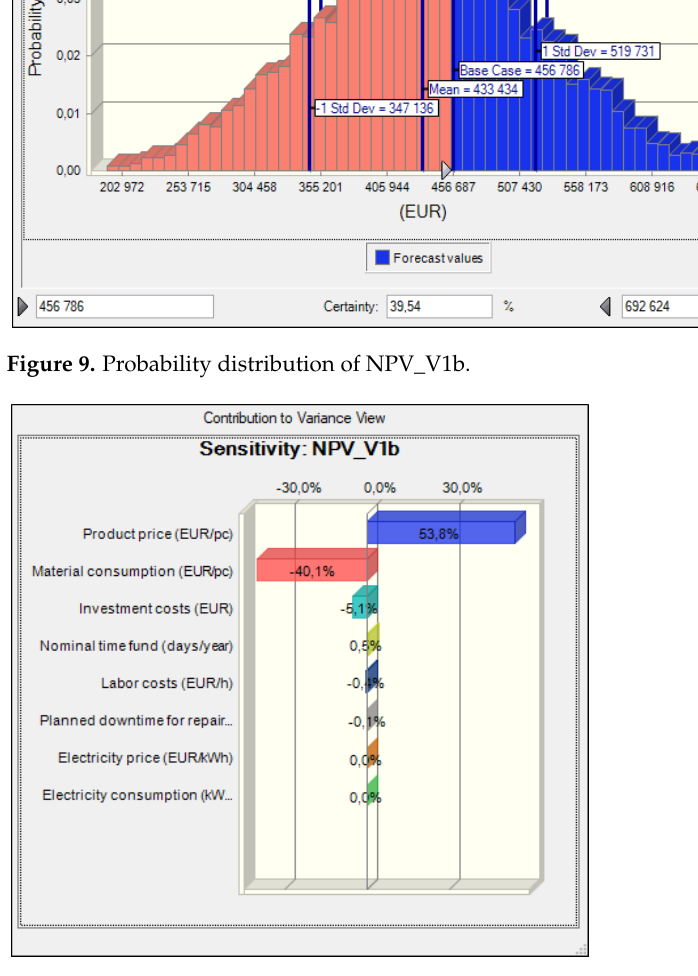
Figure 11. Tornado chart NPV_V1b. Due to the effect of taking into account the risk in the most economically advanta- geous investment variant V1b (see Table 9), there was a decrease in mean NPV_V1b com- pared to the expected value of NPV_V1b by EUR 23,352, which represents a decrease of 5.1%.